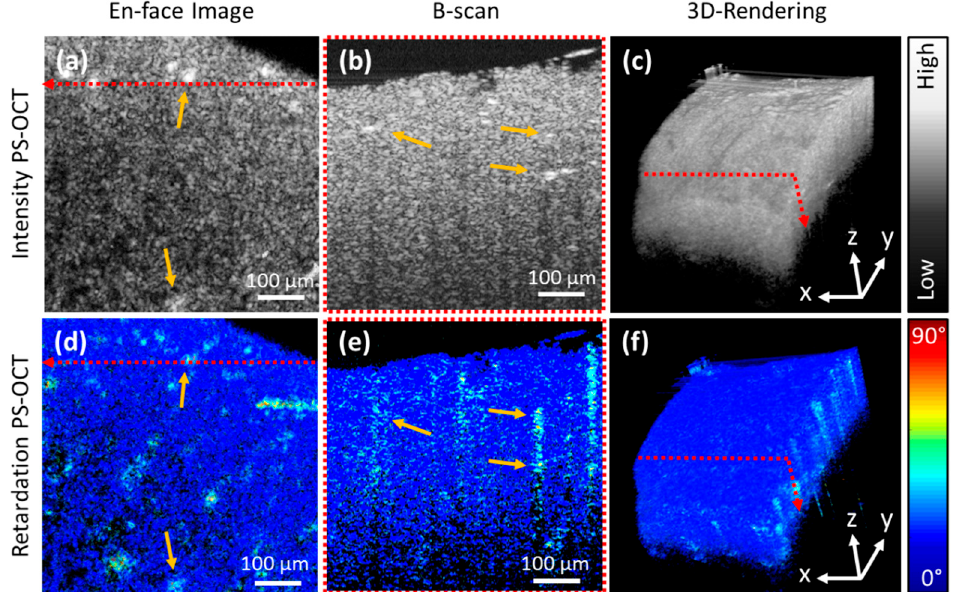
Figure 1. Visualization of amyloid-beta plaques in intensity and retardation optical coherence tomography (OCT) images. ( a ) Intensity en-face projection image averaged over a depth of 10 µm 50 µ m underneath the tissue surface. ( b ) Representative intensity B-scan image. ( c ) Three-dimensional (3D) volume of intensity data. ( d ) Retardation en-face projection image averaged over 10 µ m starting 50 µ m underneath the tissue surface. ( e ) Representative retardation B-scan image. ( f ) 3D volume of retardation